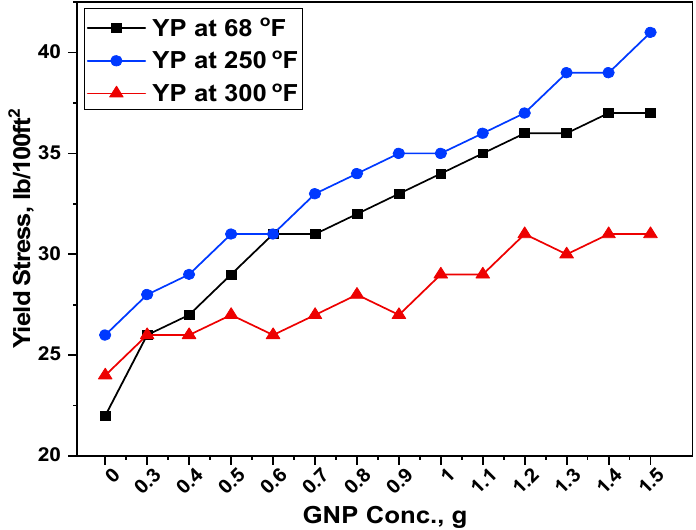
Figure 4. Response of GNP-Starch on the plastic viscosity (PV) of the formulated muds.